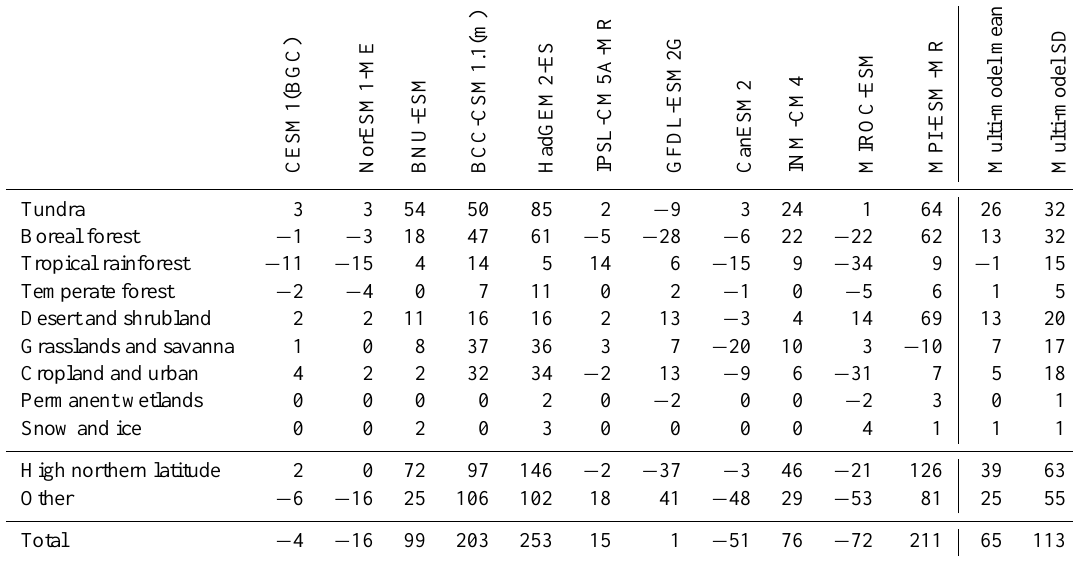
Table 1. Change in soil carbon (Pg C) between 1997–2006 and 2090–2099 biome means; the change in the high northern latitude biomes (tundra and boreal forests); the change in other biomes (tropical rainforest, temperate forest, desert and scrubland, grasslands and savanna, and cropland and urban); and the change in global soil carbon stock across all ESMs. Multi-model means and standard deviations are given in the last two